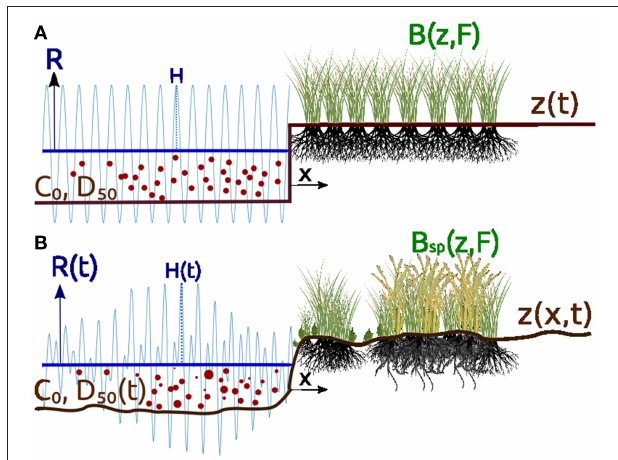
FIGURE 1 | Schematic diagrams of the inputs of a 0-dimensional accretion model. (A) Simplified model with time-invariant maritime forcing (left) and uniform topography and vegetation (right). (B) Model with more realistic, time-dependent maritime forcing and variable topography and plant associations. R is the rate of sea level rise, C 0 is the suspended sediment concentration, D 50 is the median sediment grain size, H is the maximum tidal elevation for a given tidal cycle, B is the biomass of a given species, and F is the fitness function for that